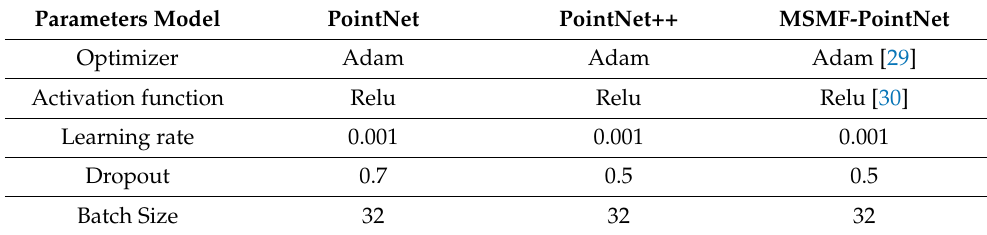
Table 3. Settings of network parameters.